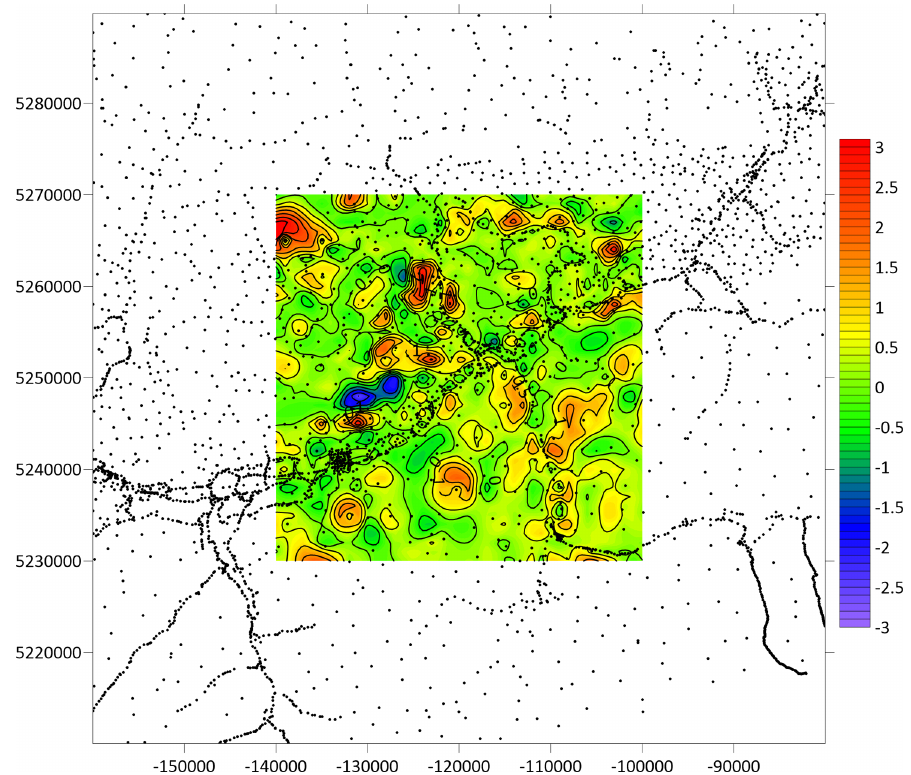
Figure 11. Interpolation error estimate (gravity difference between gravity fields predicted by the EQS model and by 2D interpolation; contour interval 0.1mGal, color bar in milligals (mGal) and axis coordinates in meters; Gauß–Krüger projection,